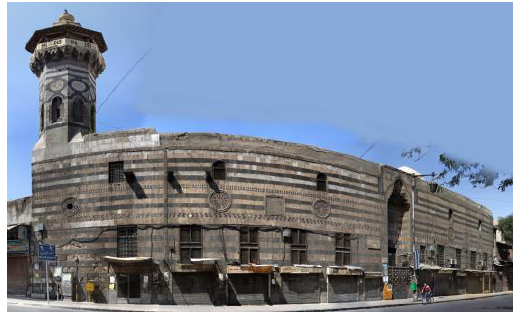
Figure 4 - Damascus – Al Sybahieh